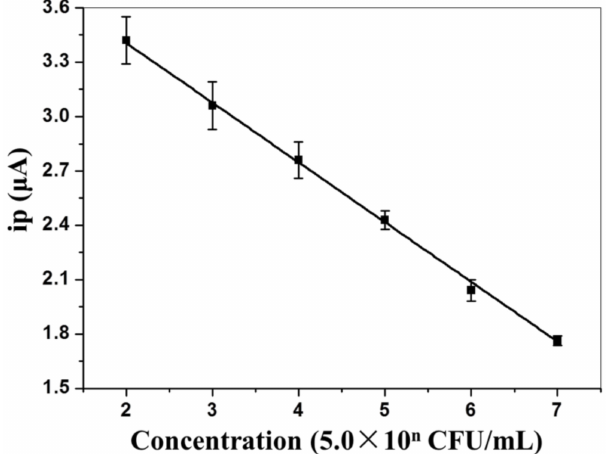
Figure 9. Calibration plot of peak currents versus concentration of E. coli